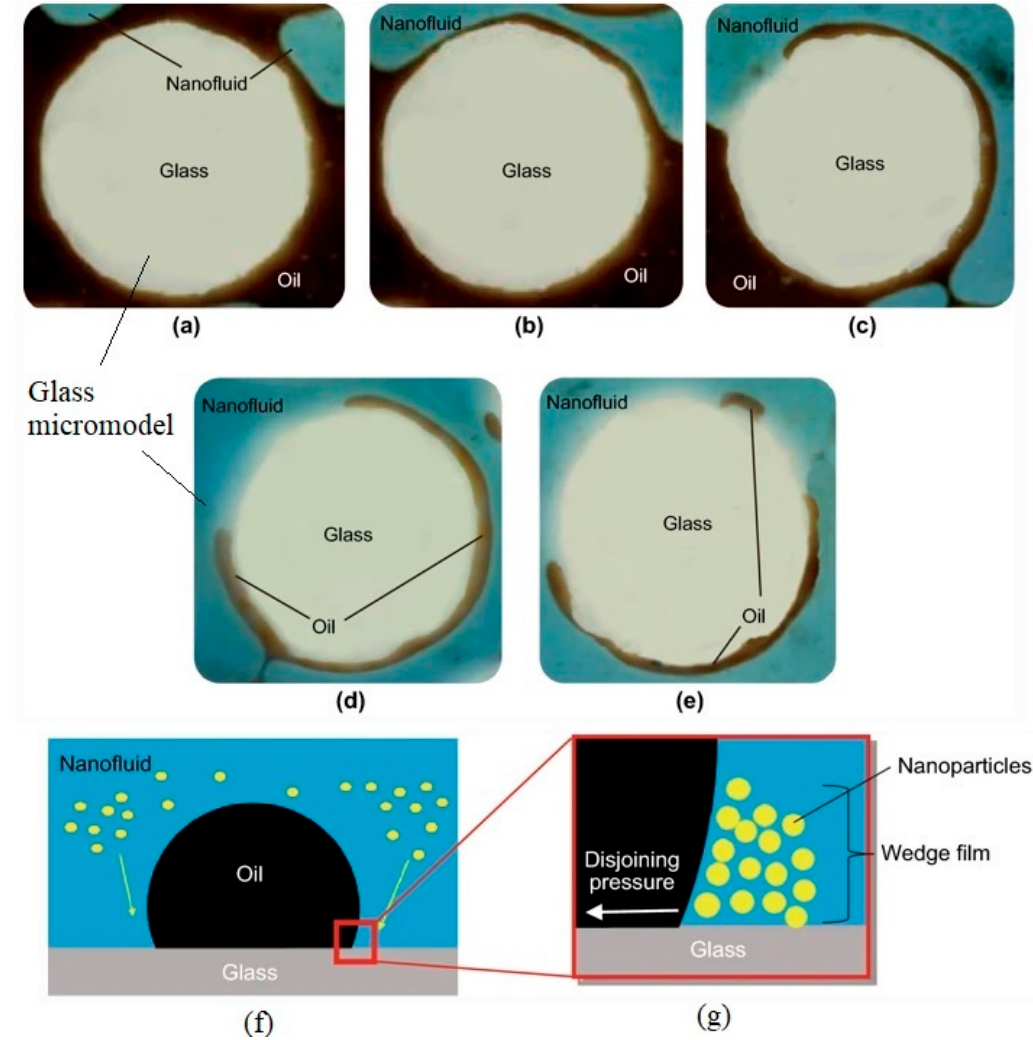
Figure 8. Surface wettability changes. Pore-scale views of the micromodel during nanofluid flooding for a period: ( a ) initial time, ( b ) 1000 s, ( c ) 2000 s, ( d ) 3000 s, ( e ) 5000 s of nanofluid injection; ( f , g ) illustration of oil droplet being loosened from the glass surface by adsorption of silica NPs